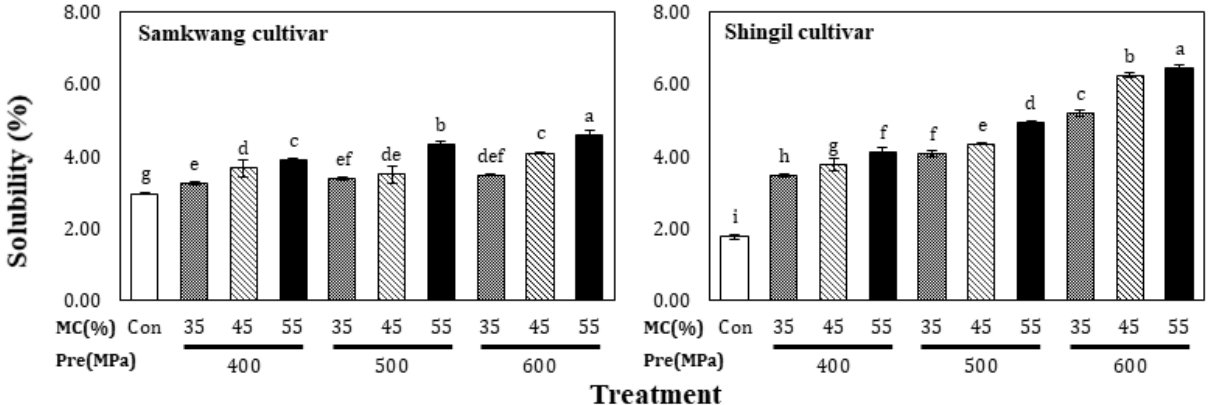
Control, MC: Moisture content of rice flour. Different small letters in the same items indicate a